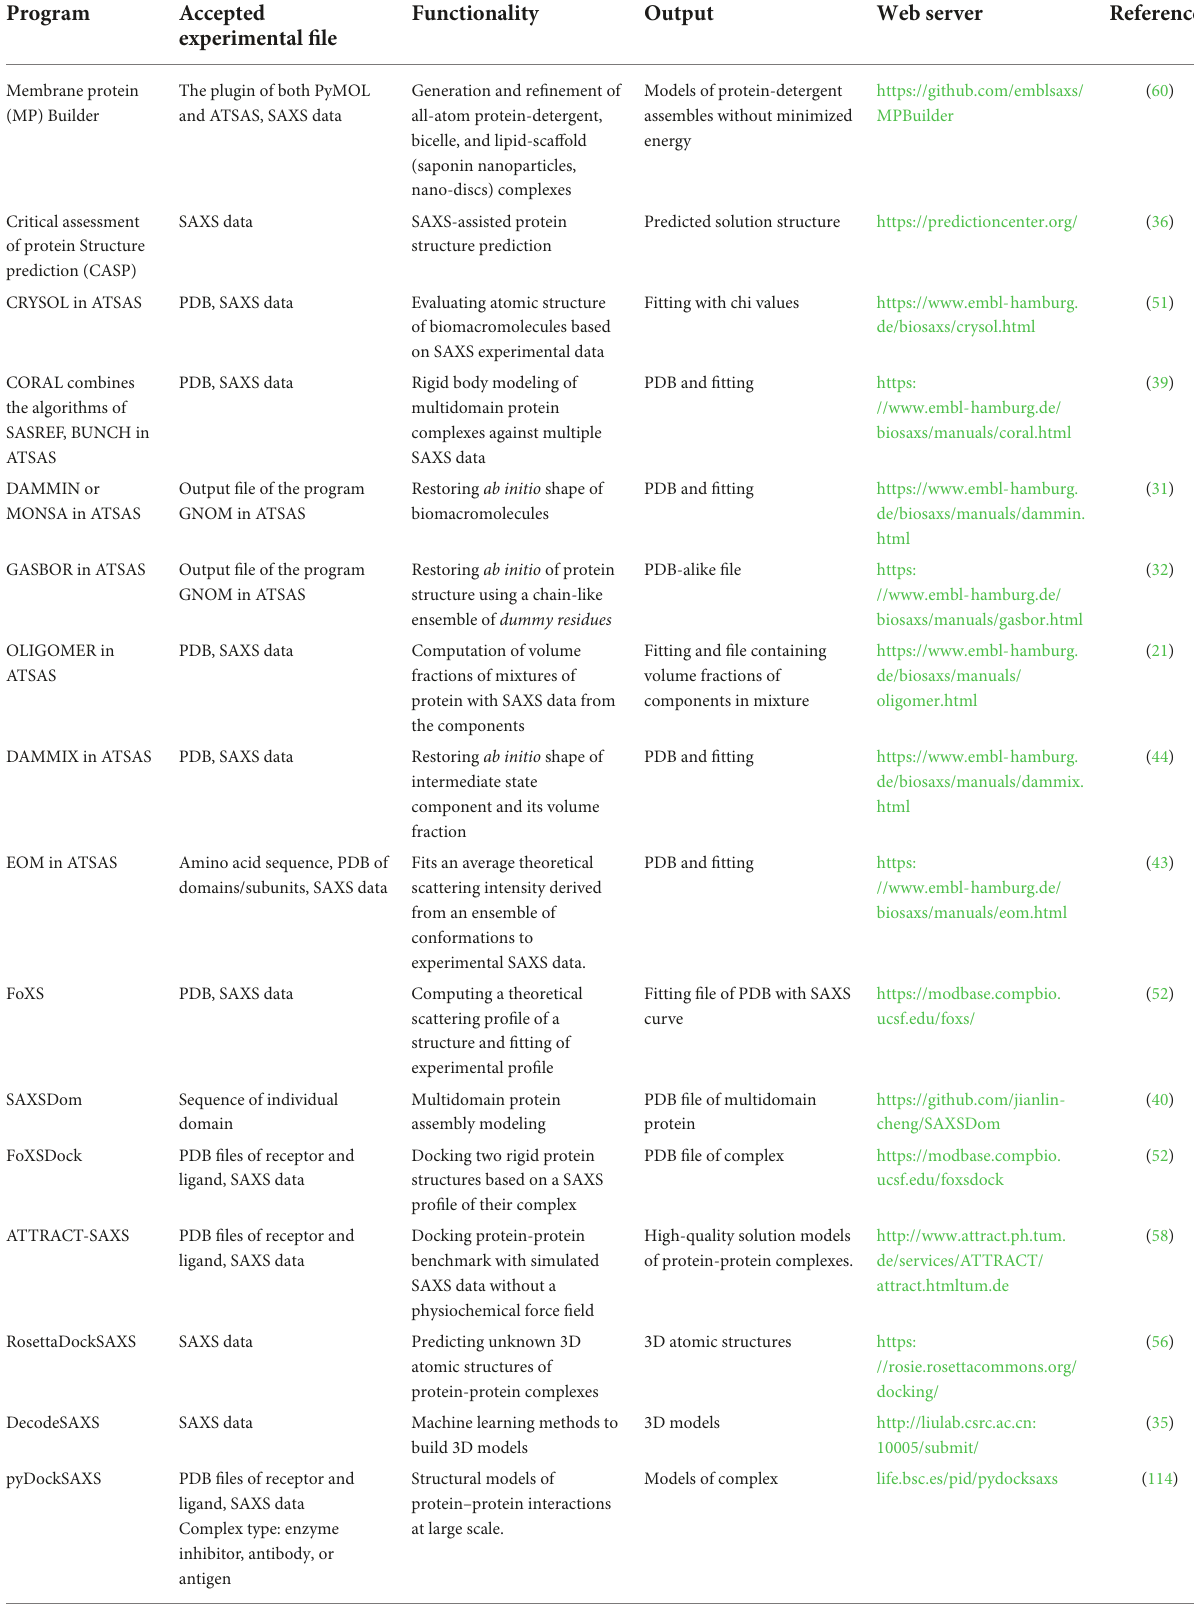
TABLE 1 List of some of the available software programs used in the analysis and reconstruction of models based on small-angle X-ray scattering (SAXS) data.